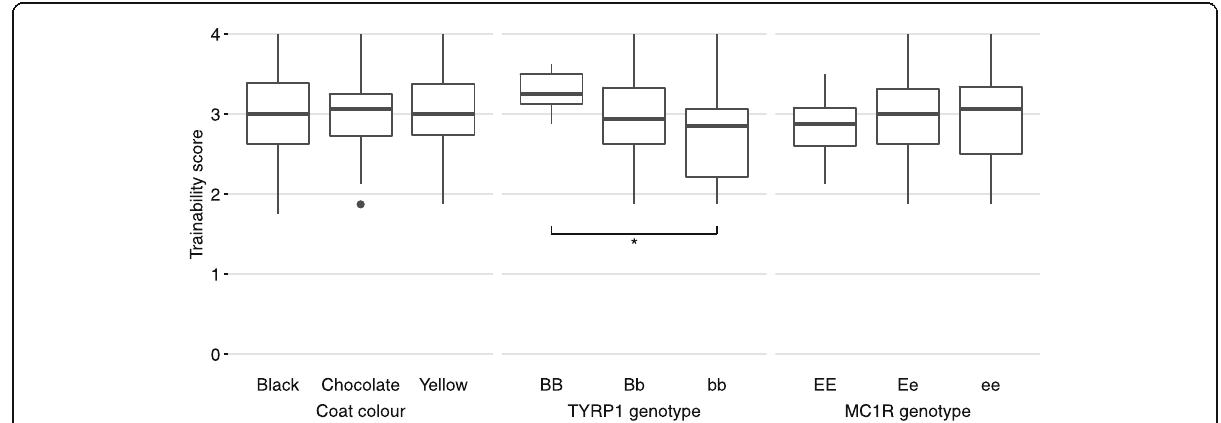
Fig. 2 boxplots of Trainability score. Significant differences between the groups calculated by Mann Whitney U test with Bonferroni correction. Coat colour ( n = 224), TYRP1 genotype ( n = 63), MC1R genotype ( n = 63) *: P <